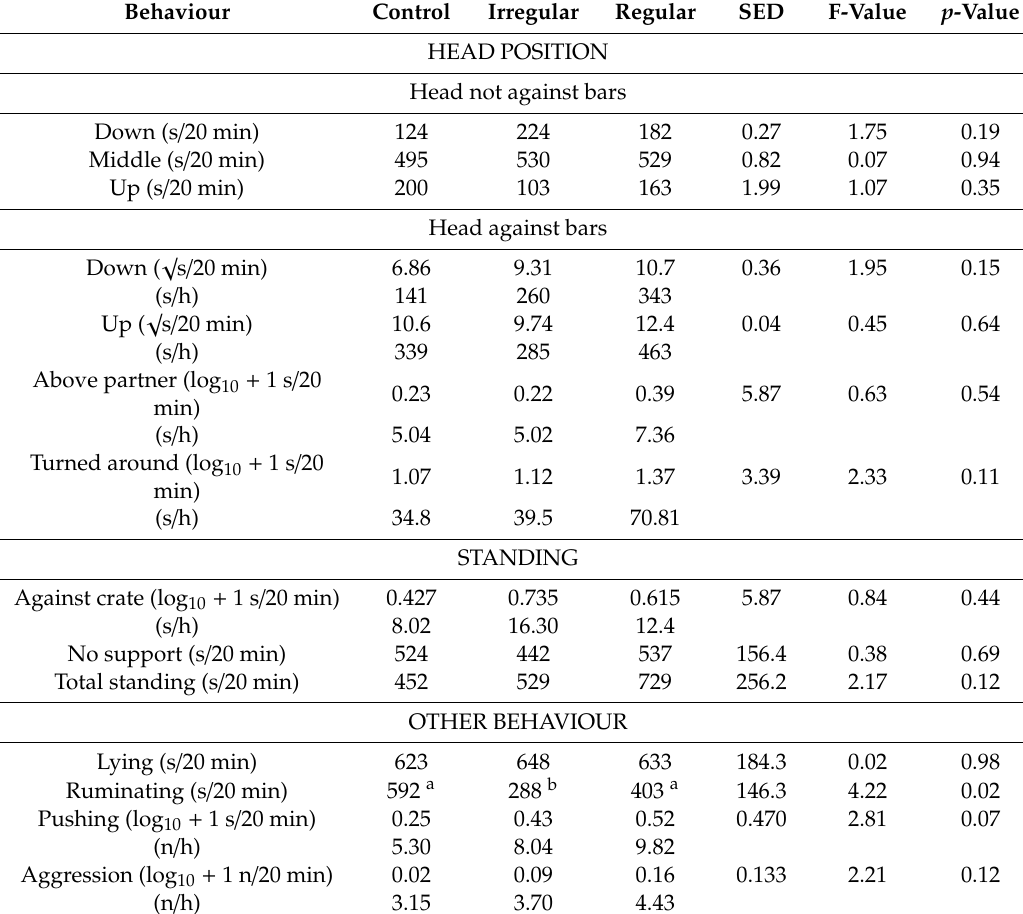
Table 3. E ff ects of motion treatment (Control, Irregular and Regular) on the behaviour responses of sheep during simulated sea conditions.